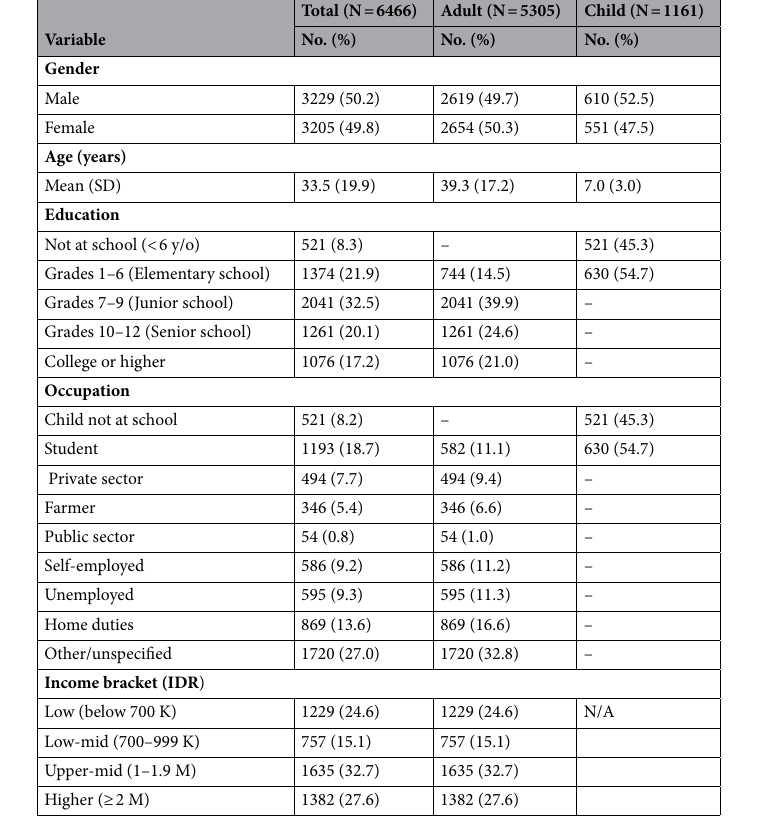
Table 1. Demographic characteristics of